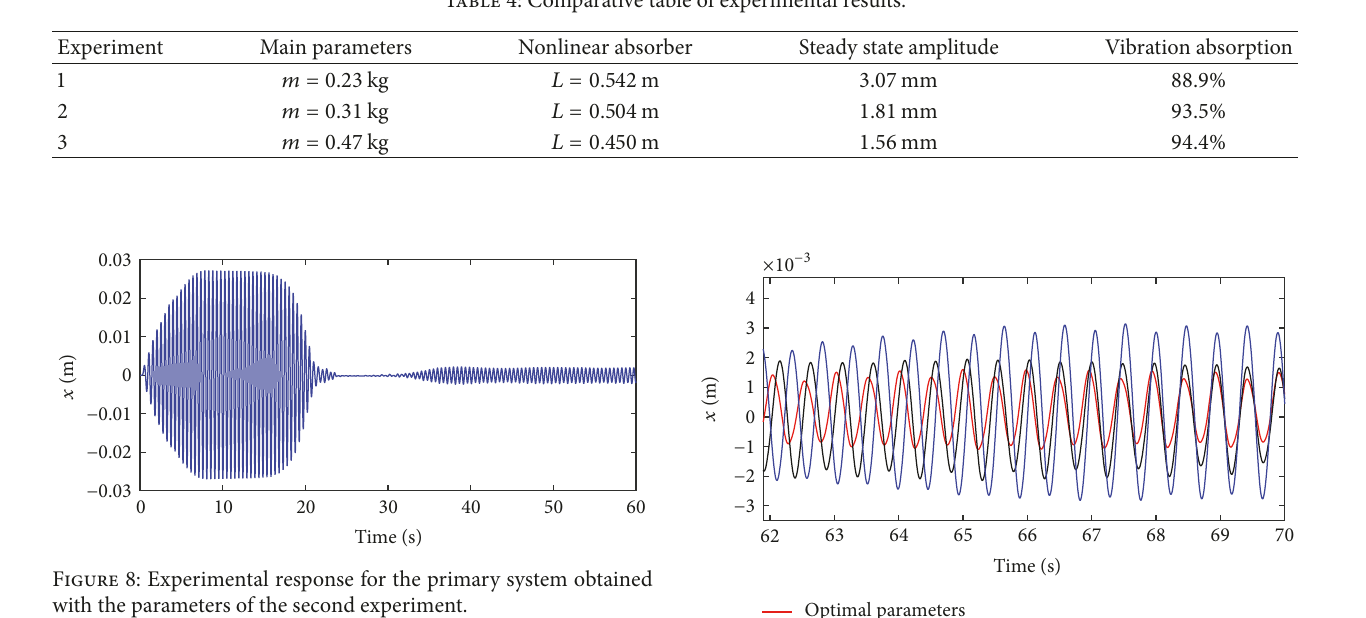
Table 4: Comparative table of experimental results.